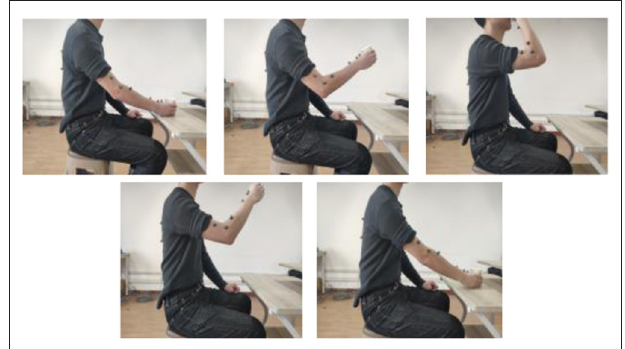
FIGURE 2 | Coordinated training, Task 1: drinking water.